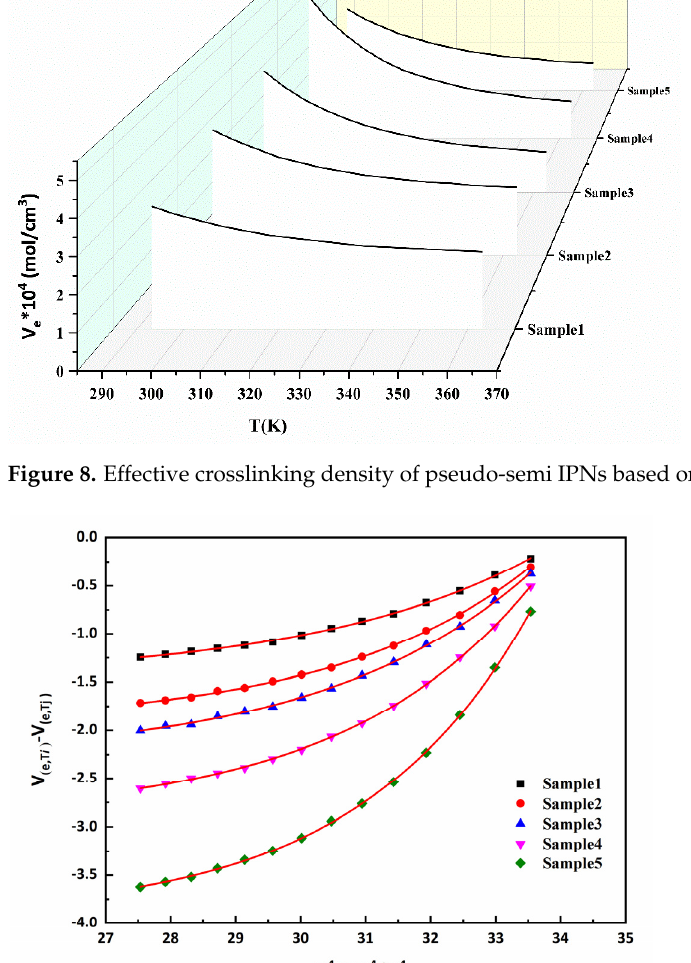
Figure 9. Relationships between Δ V e and 1/T of pseudo-semi IPNs. Red line is the regression results. Table 3. Correlation coefficients as well as V c and V p constants obtained by experiments and theoretical